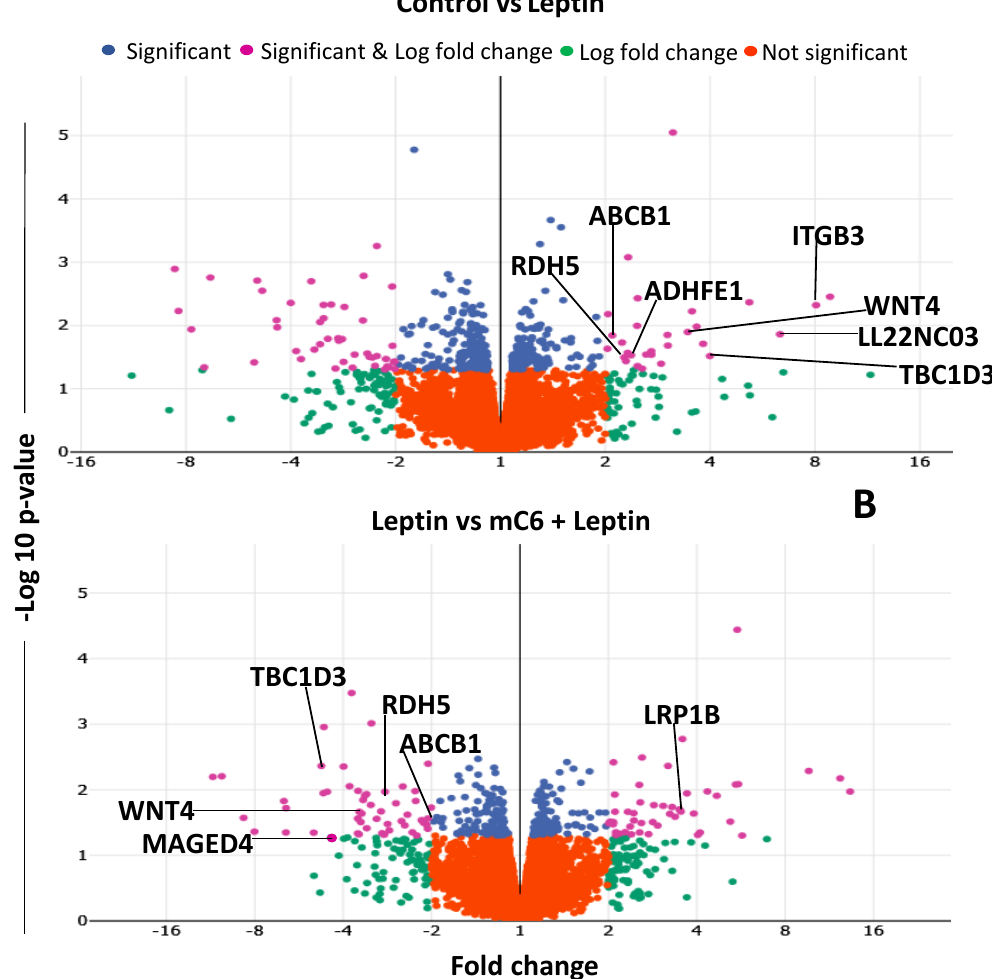
Figure 8. Volcano plots of leptin effects on changes of gene expression in triple negative breast cancer cells. cells. ( A ) Untreated cells (control) versus leptin-treated cells. ( B ) Leptin-treated cells versus (A) Untreated cells (control) versus leptin-treated cells. (B) Leptin-treated cells versus leptin +mC6 treated cells.